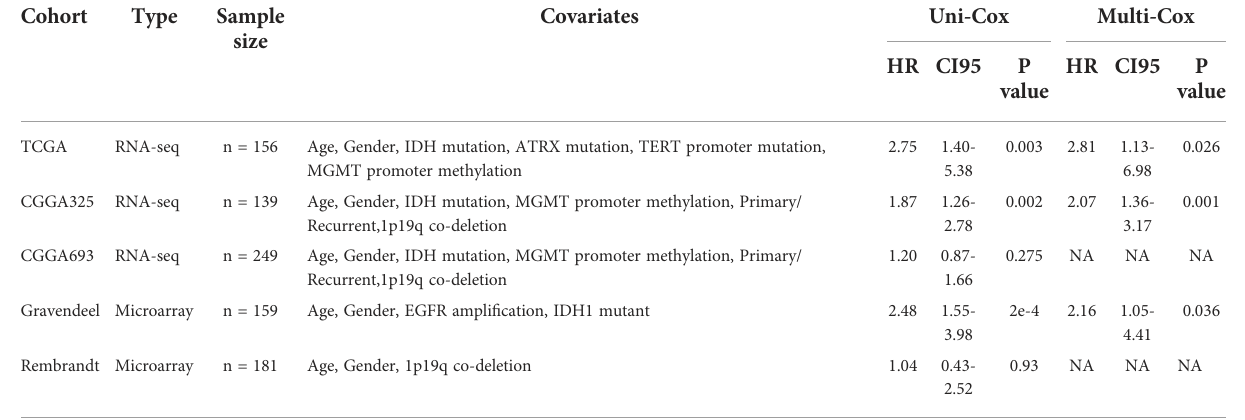
TABLE 2 Cox regression analysis of the MRGPI in validation data